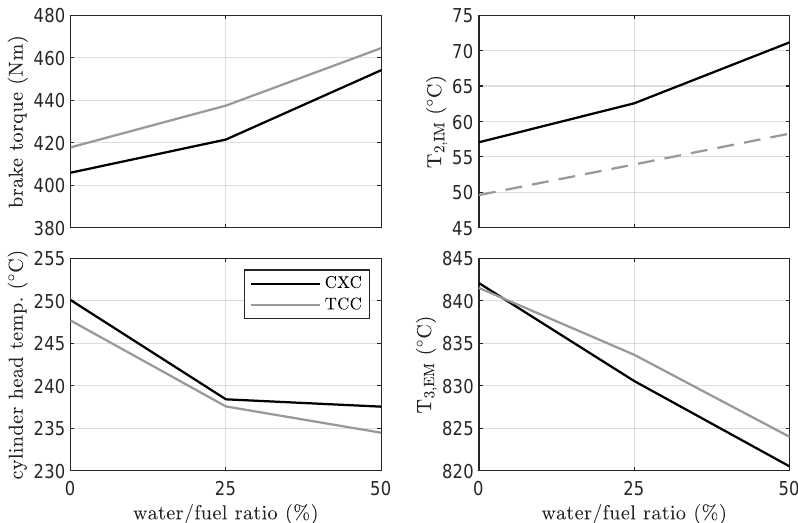
Figure 11. Effects of water injection on the full load at a given centre of combustion of 20 ◦ CA at an engine speed of 2750 rpm.